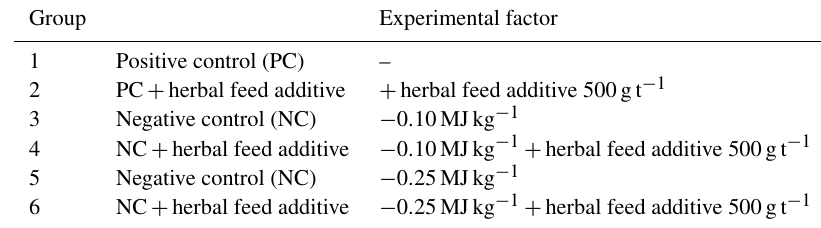
Table 2. Experimental design. Group Experimental